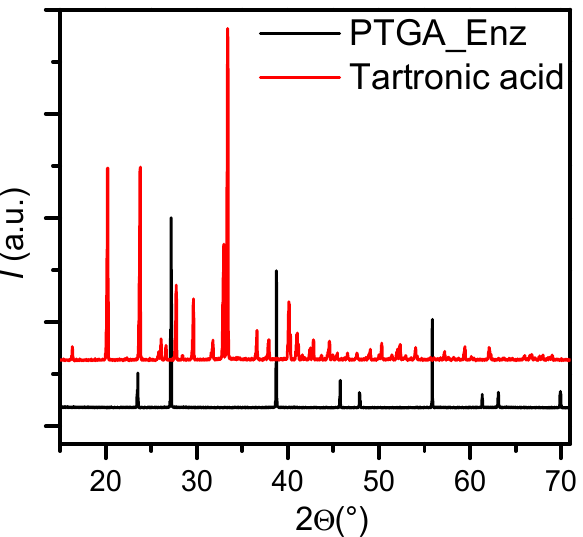
Figure 6. Diffraction pattern of PTGA_Enz (black line) and tartronic acid TA (red line).